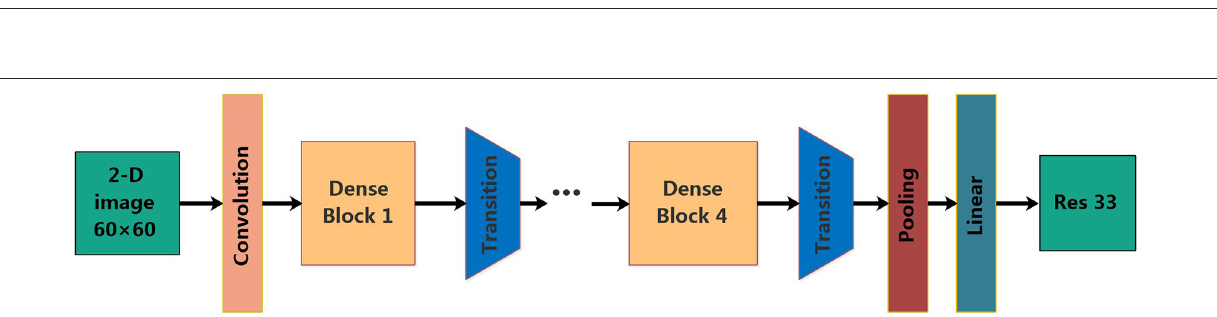
FIGURE 1 | The workflow of MI_DenseNetCAM. (A) Cancer classification and prediction through MI and deep learning combined analysis from pan-cancer datasets. (B) Principle diagram of the Guided Grad-Cam algorithm.